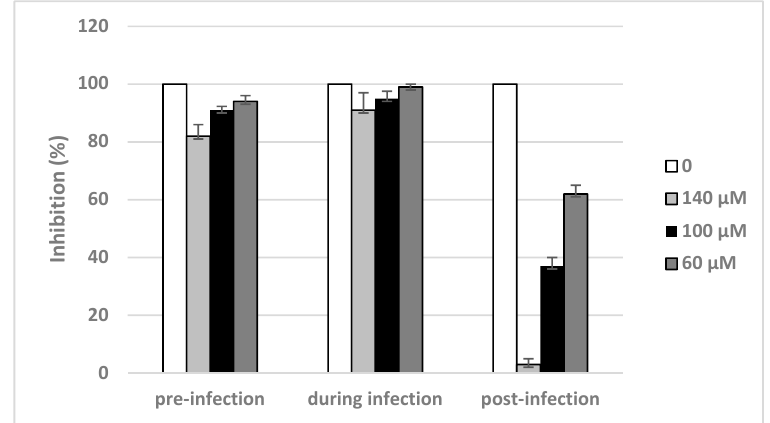
Figure 4. Inhibitory effects of compound 2 on different stages of viral infection. Compound 2 was added to MDCK cells overnight before adsorption (I), during viral adsorption for 1 h (II) or post-viral adsorption for 72 h (III). A/ostrich/Denmark/725/96 (H5N2) infected MDCK cultures were incubated for 72 h. The cell viability was evaluated by MTS assay.